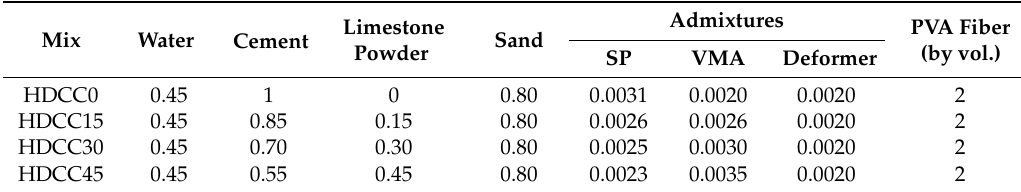
Table 2. Mix proportion of highly ductile cement composites (HDCCs) (proportion by weight of cement and limestone